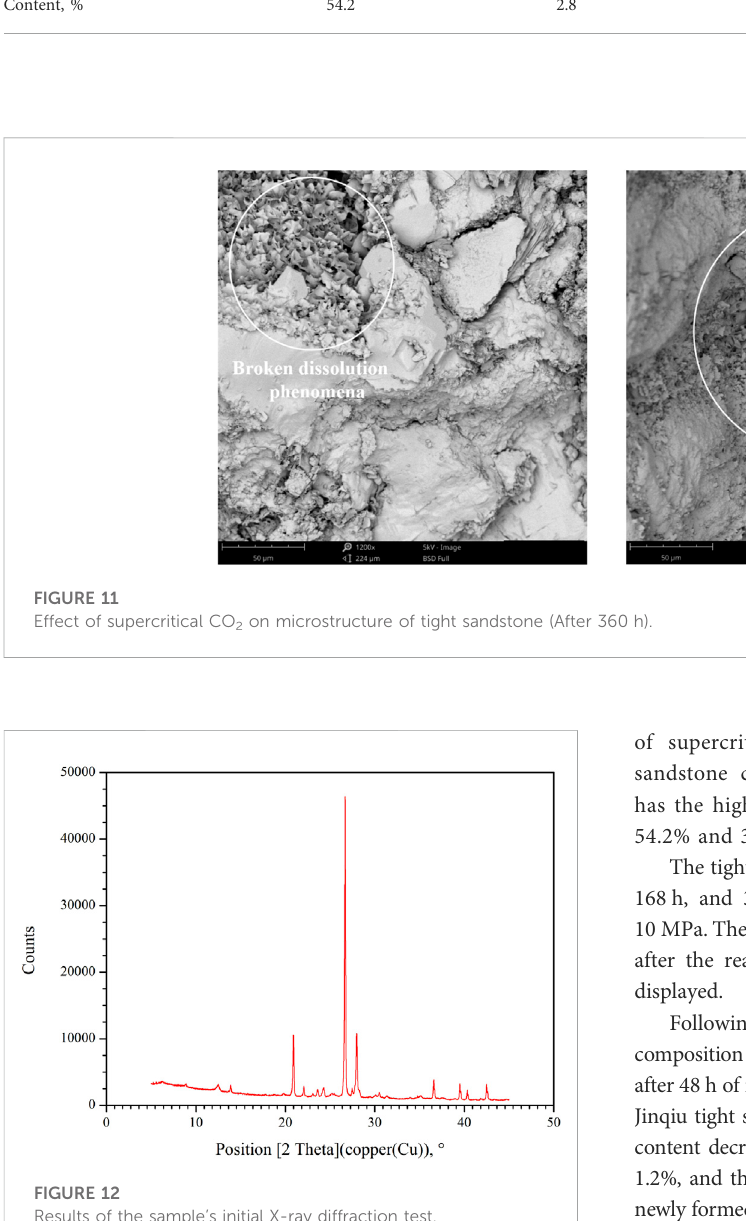
FIGURE 12 Results of the sample ’ s initial X-ray diffraction test.